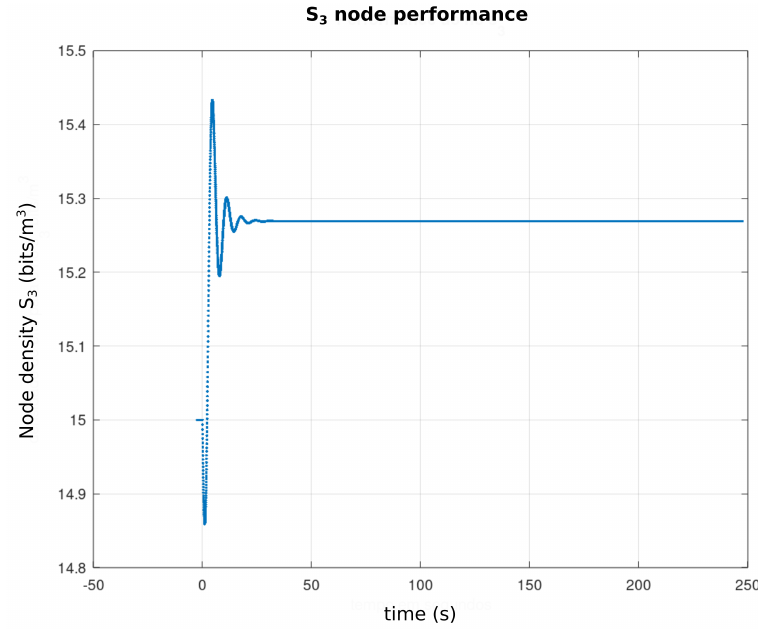
Figure 15. S 3 node performance graph.